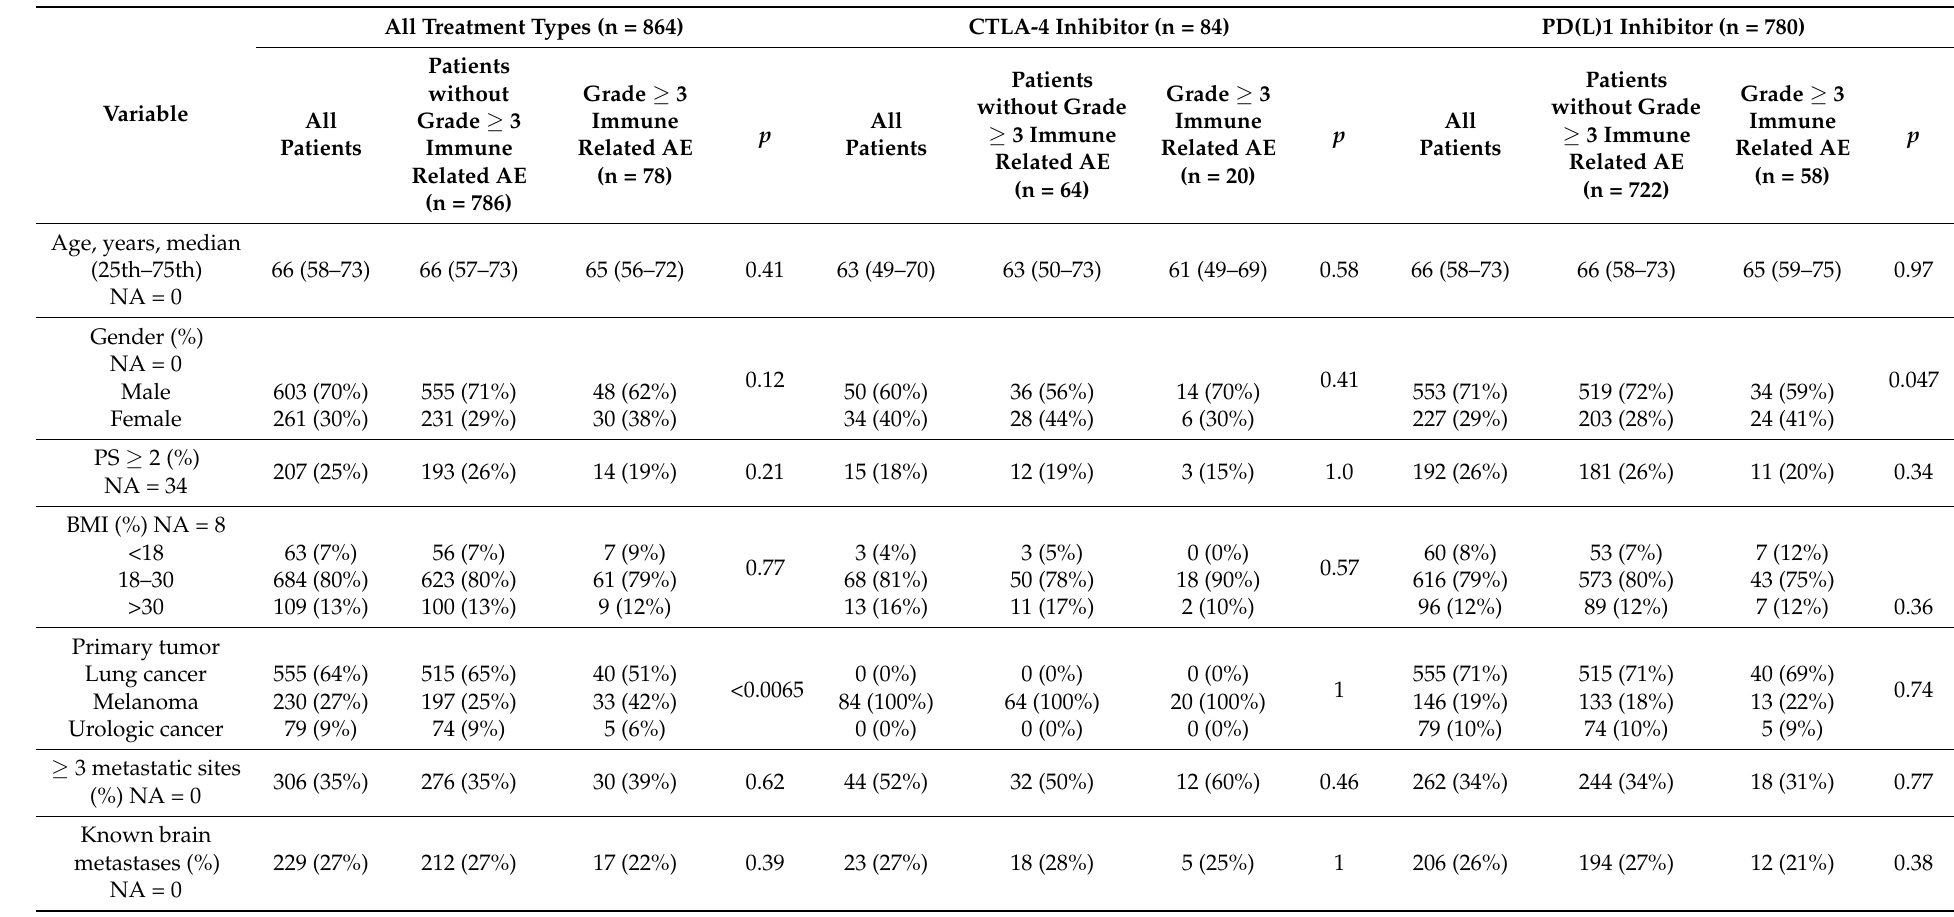
Table 1. Patients characteristics, AE = Adverse Event; BMI = Body mass index; PS = Performans